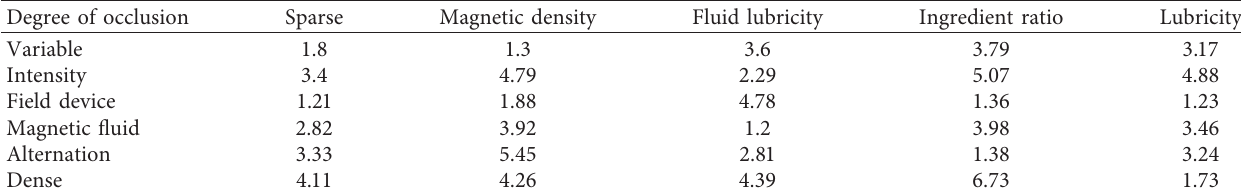
Table 4: Steady state and dynamic performance of tilting pad sliding bearing.